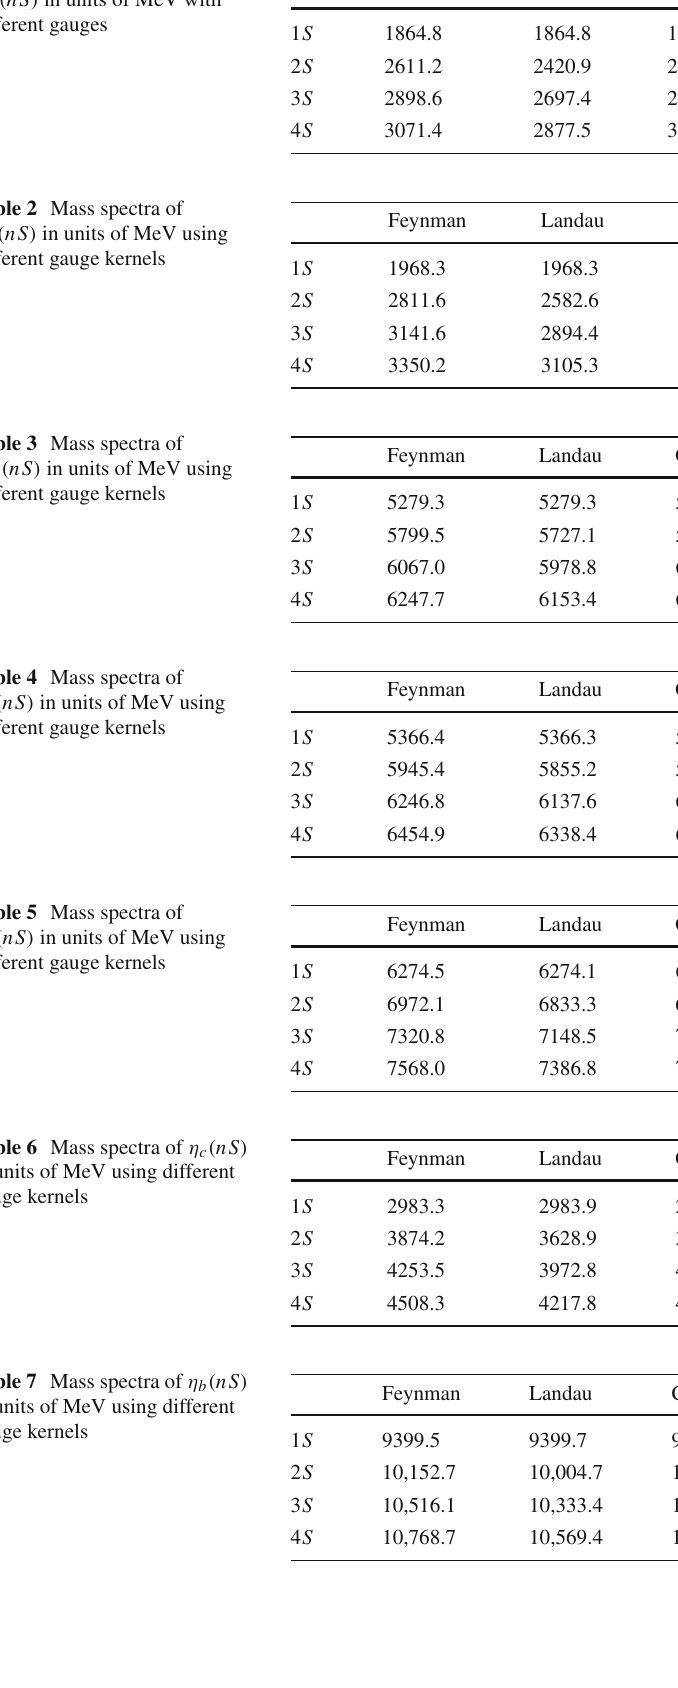
Table 1 Mass spectra of D 0 ( nS ) in units of MeV with different gauges